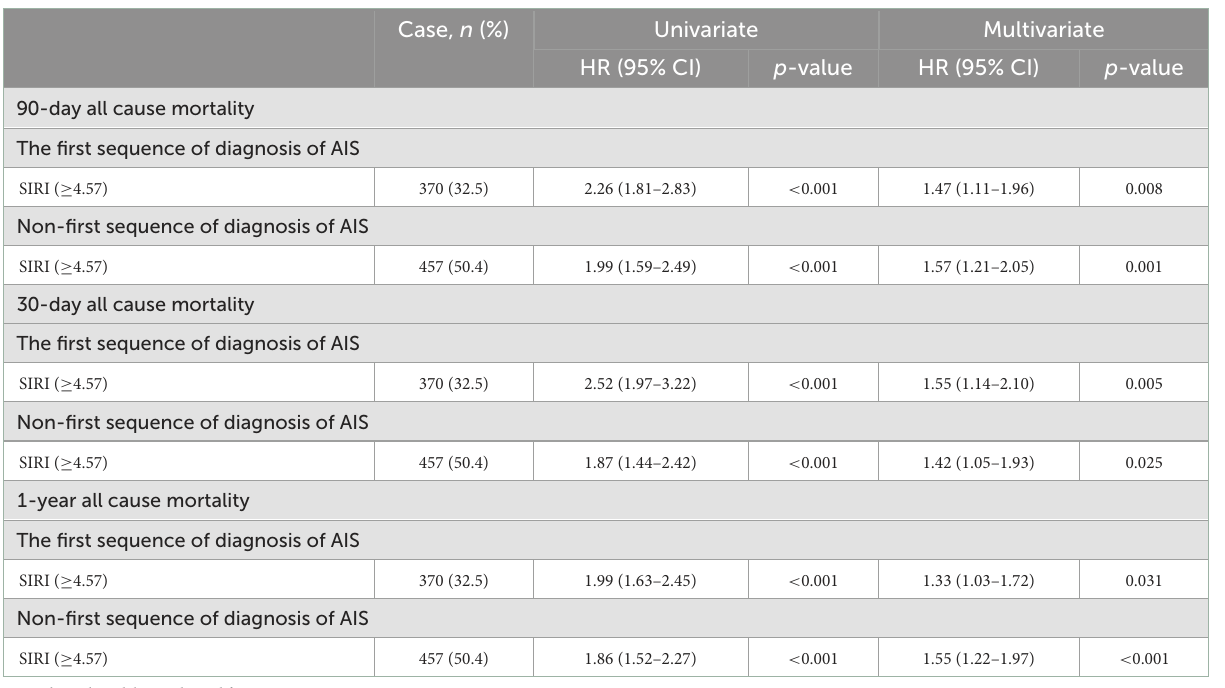
TABLE 3 Sensitivity analysis of the association between SIRI and all-cause mortality in AIS patients (adjustment through multivariate Cox regression